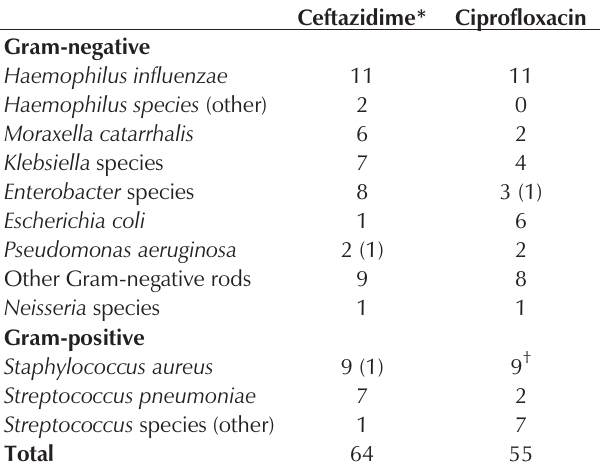
Sputum pathogens isolated, evaluable